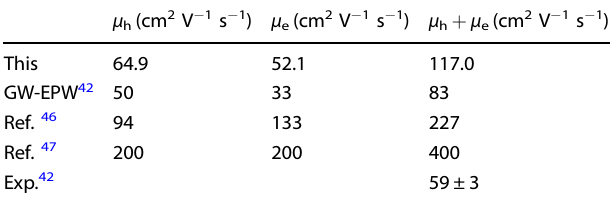
Table 3. Charge mobilities of MAPbI 3 Hole ( μ h ), electron ( μ e ) and total ( μ h + μ e ) mobilities of orthormobic MAPbI 3 at ambient